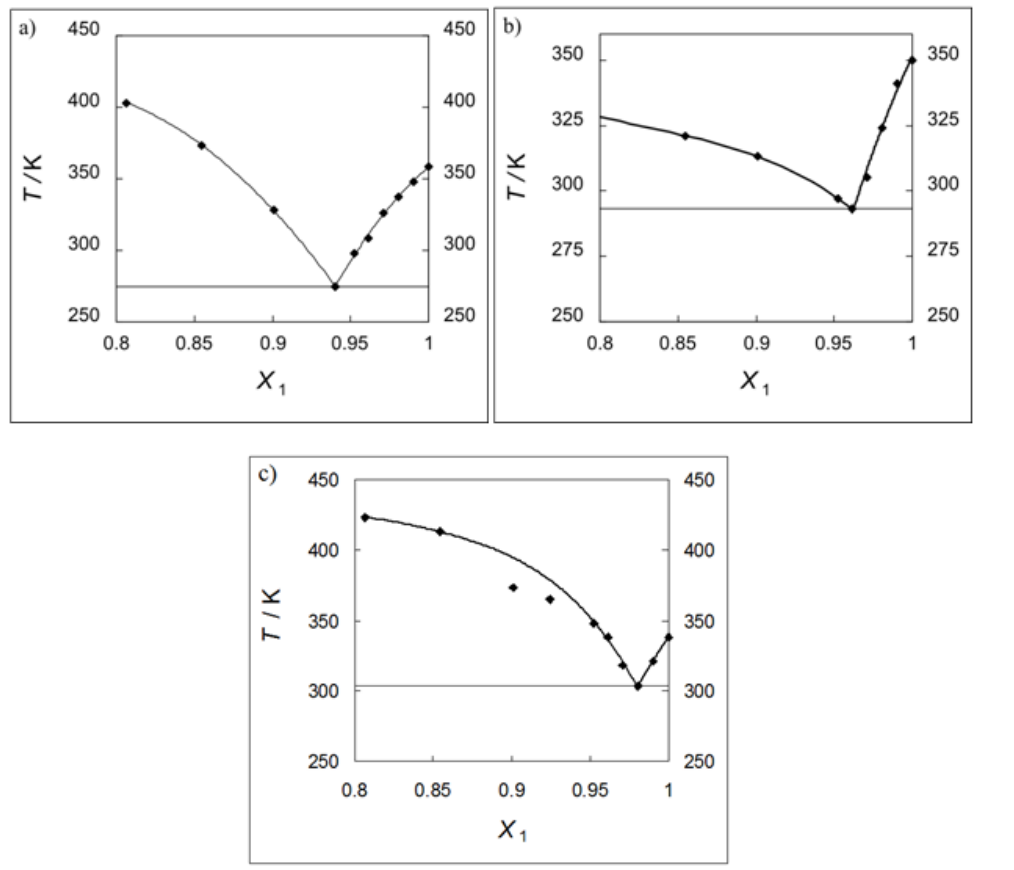
Figure 1. SLE phase diagrams of the binary mixtures: ( a ) {[EMIM][Cl] (1) + β -CD (2)}; ( b ) {[EMIM][Br] (1) + β -CD (2)}; ( c ) {[BMIM][Cl] (1) + β -CD